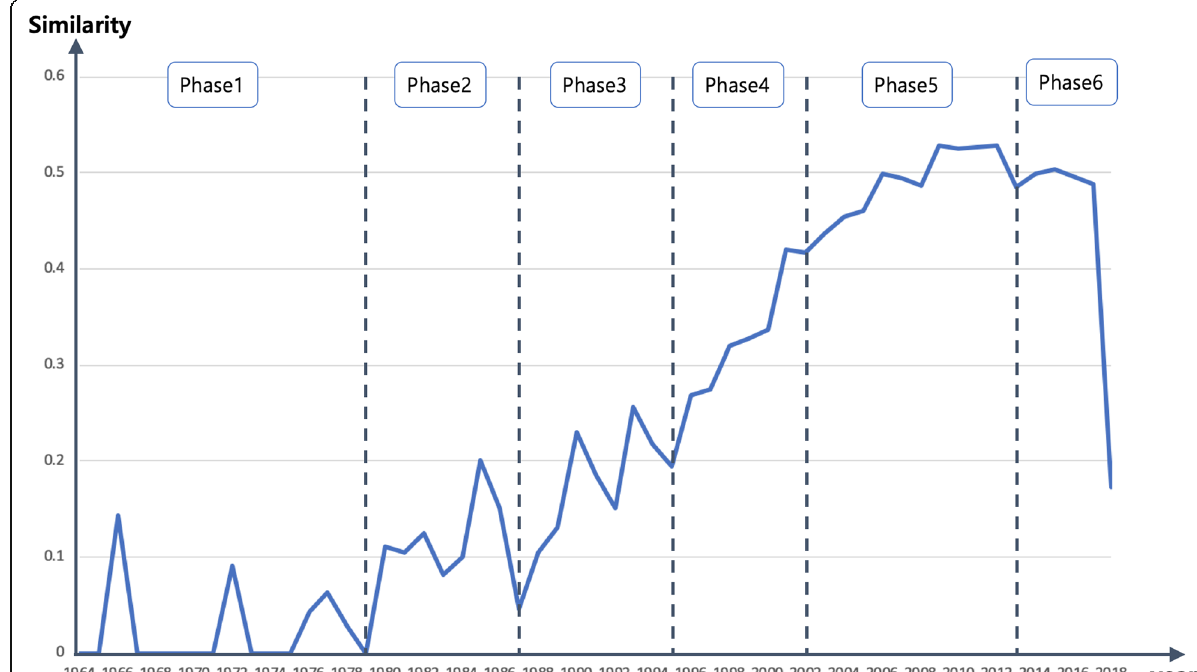
Fig. 2 Chart of changes in the similarity of the keywords by year. The changes in the weighted Jaccard similarities between two frequency lists of keywords in a year and the previous one are